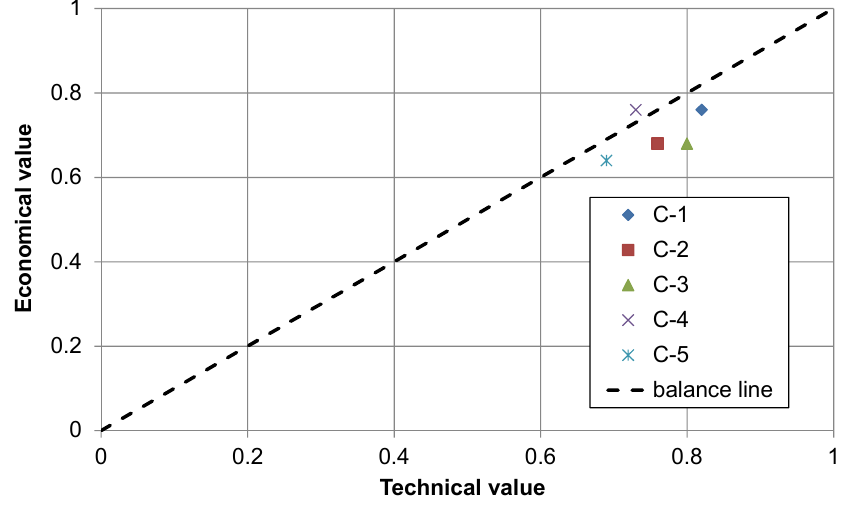
Figure 1. Graphical representation of the concept evaluation results.